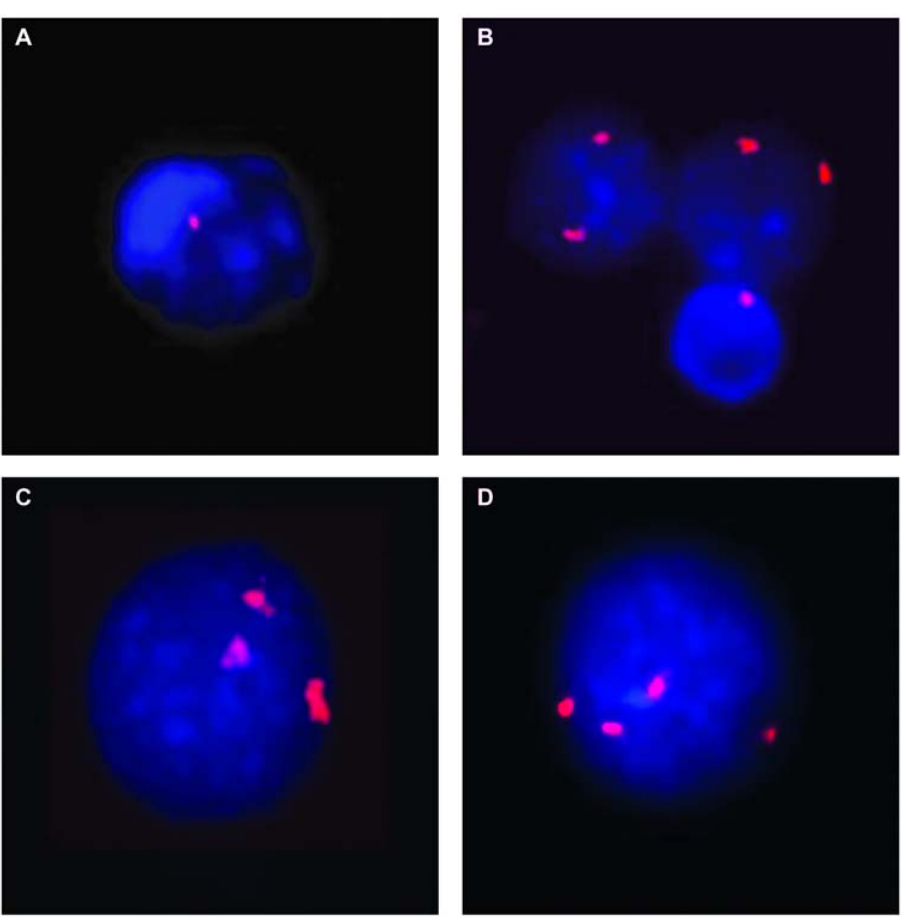
Figure 2. Interphase cells hybridized with a FISH probe for the centromere of the X chromosome. A) A cell with one signal for the centromere of the X chromosome or monosomy X. B) Two normal cells showing two signals for the X chromosome, and one cell with monosomy X. C) A cell showing trisomy X. D) A cell with tetrasomy X.